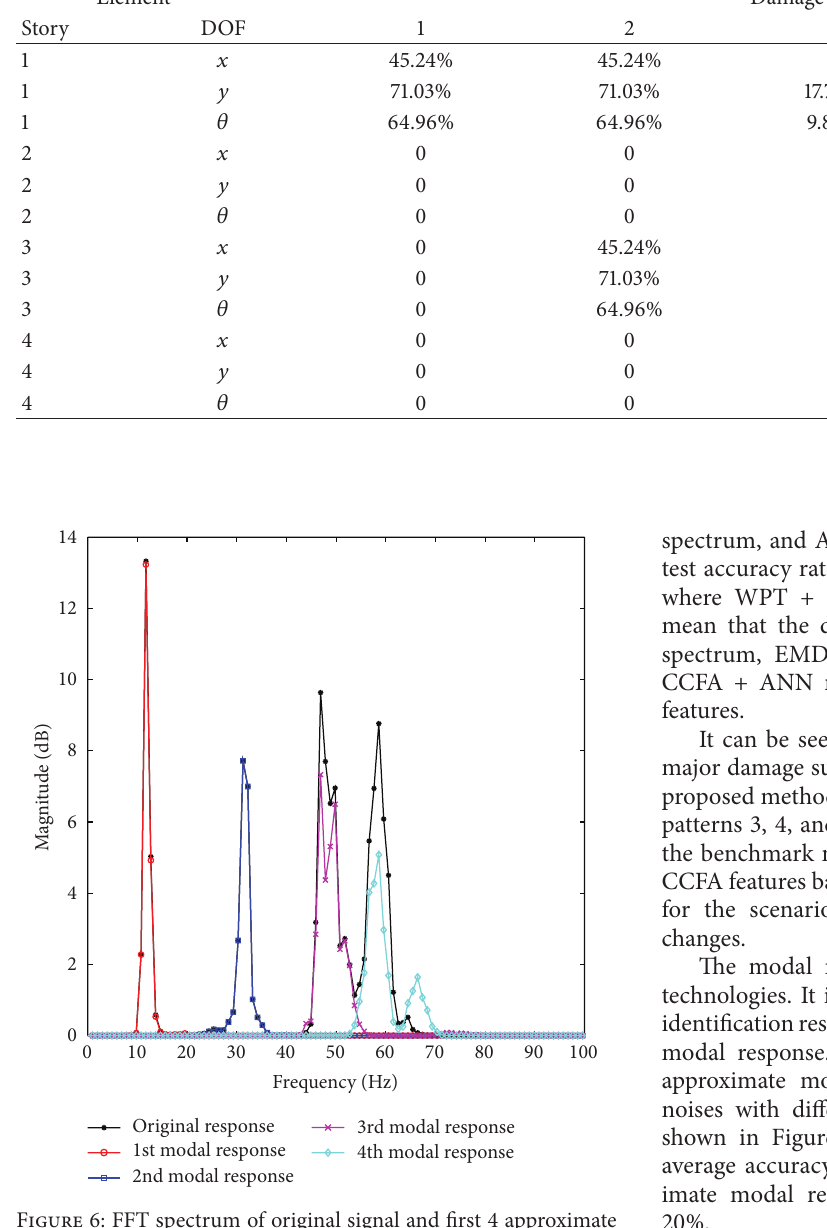
Figure 6: FFT spectrum of original signal and first 4 approximate modal